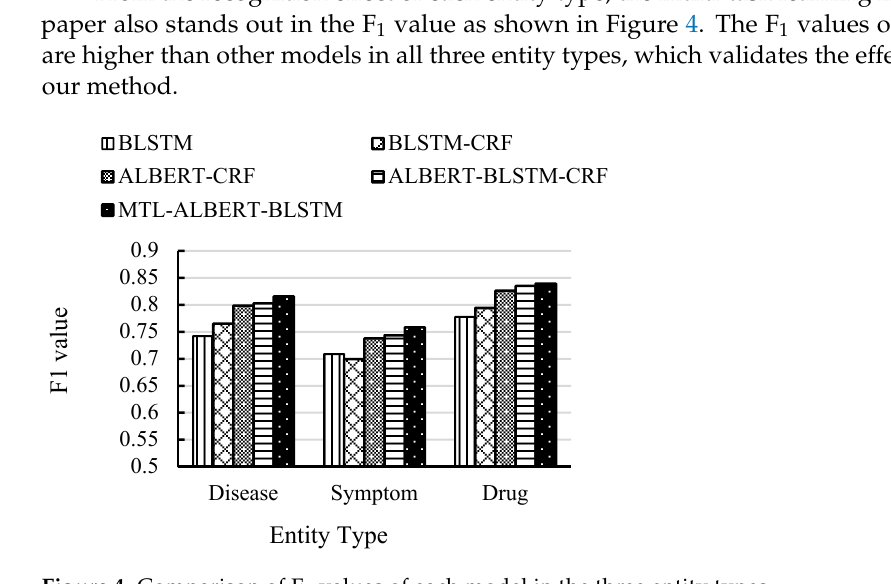
Figure 4. Comparison of F1 values of each model in the three entity types.